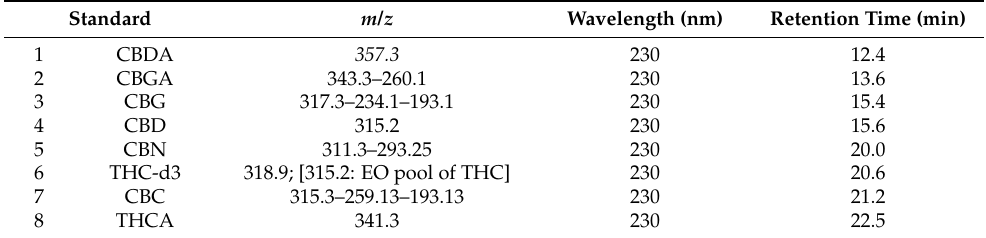
Table 9. Mass-to-charge ratios ( m / z ) and retention times related to the investigated terpenopheno- lic